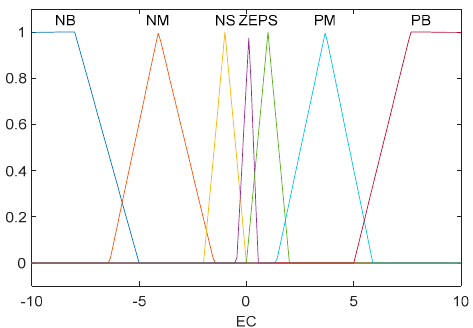
Figure 4. Membership (error of change) function of fuzzy input (error).